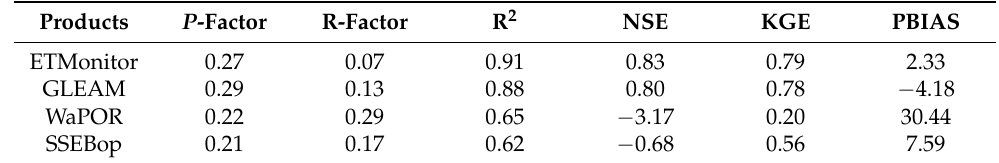
Table 8. Performance metrics of SWAT_Hargreaves when calibrated using remote sensing ETa products for the year 2009.